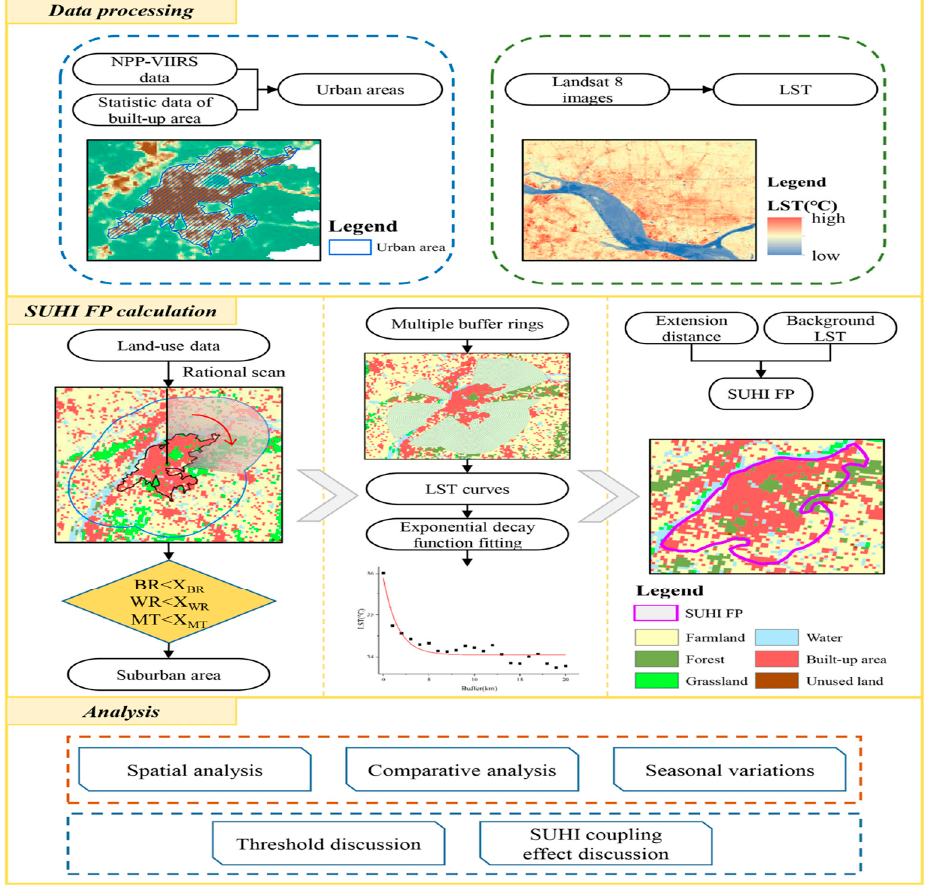
Figure 1. The flowchart of major procedures used in the study. LST : land surface temperature, BR: built-up area rate, X BR : threshold of BR, WR: water body rate, X WR : threshold of WR, MT: merge tolerance, X MT : threshold of MT, SUHI FP: surface urban heat island footprint.